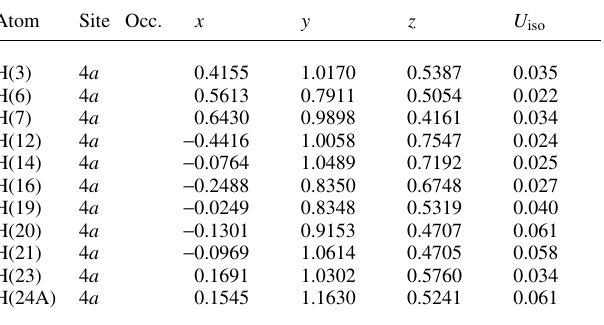
Table 2. Atomic coordinates and displacement parameters (in Å 2 ) .